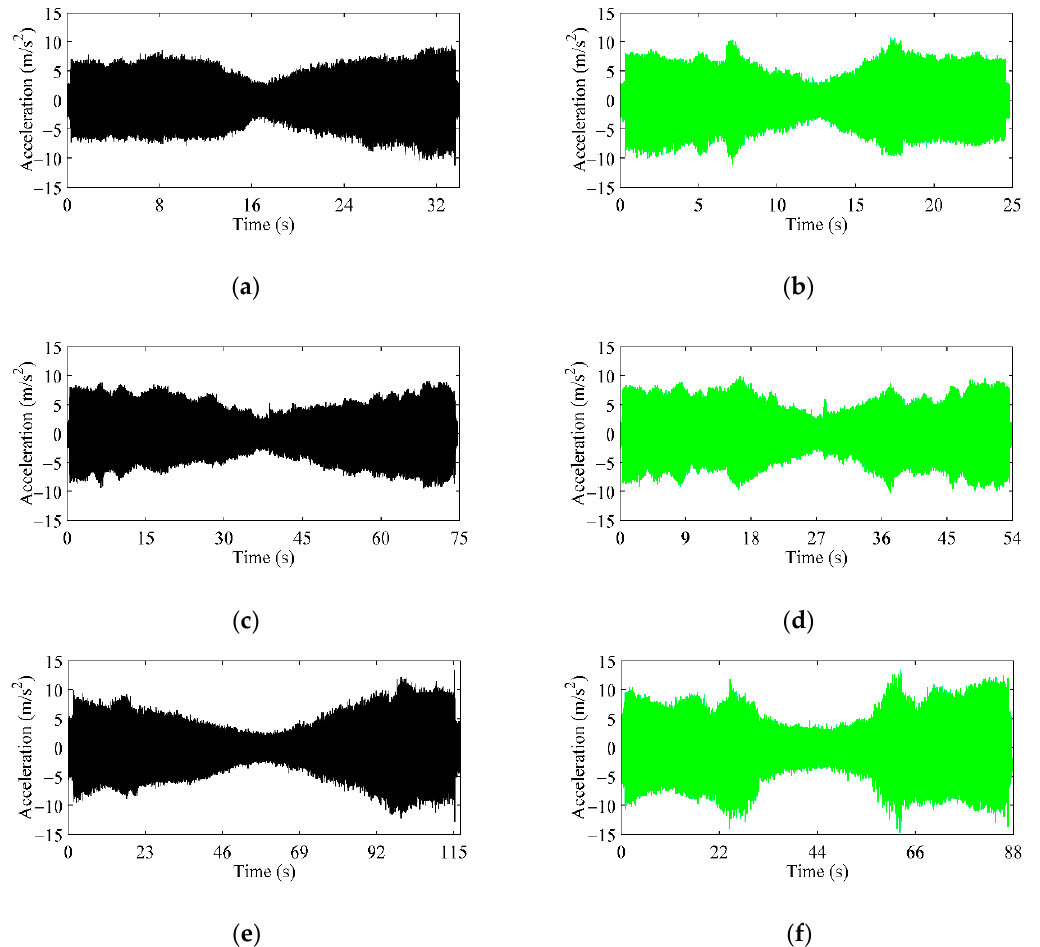
Figure 16. Time-domain vibration signals for a single contour line: ( a , b ) contour at HP; ( c , d ) contour at MP; ( e , f ) contour at LP; ( a , c , e ) contour without feed rate variation; ( b , d , f ) contour with the feed rate variation.